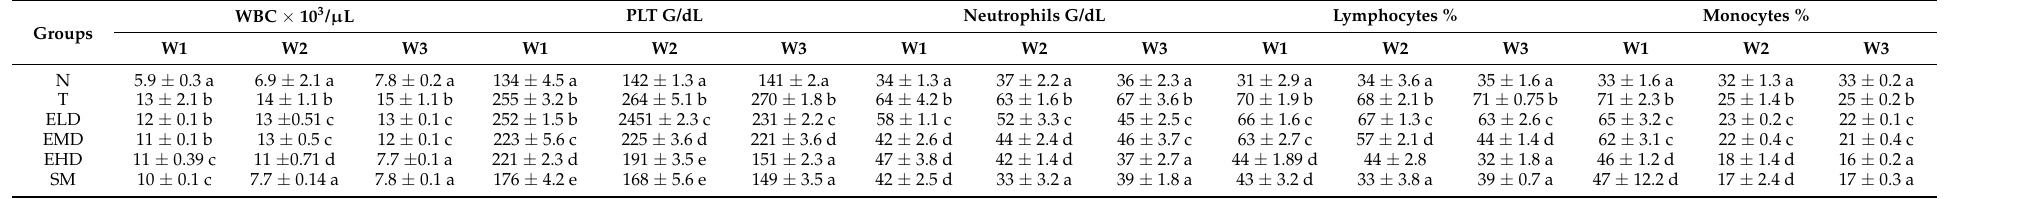
Table 2. The effects of DO.AQ extracts on leucocytes and other associated parameters of various experimental